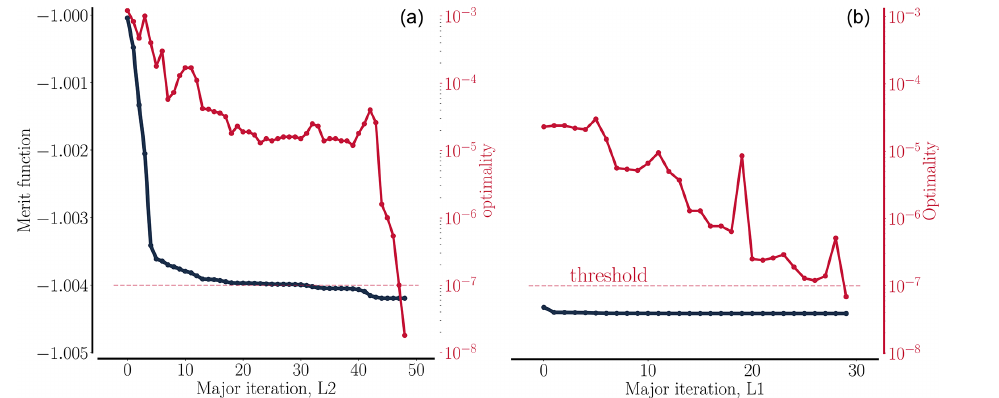
Figure 12. Example of optimization procedure using grid sequencing: the result from grid level L2 (a) is used as a starting point on grid level L1 (b) to save time. The optimizations are called SPL2e3cb and SPL1e3hb and also figure both in Table 6 and in Fig. 10.